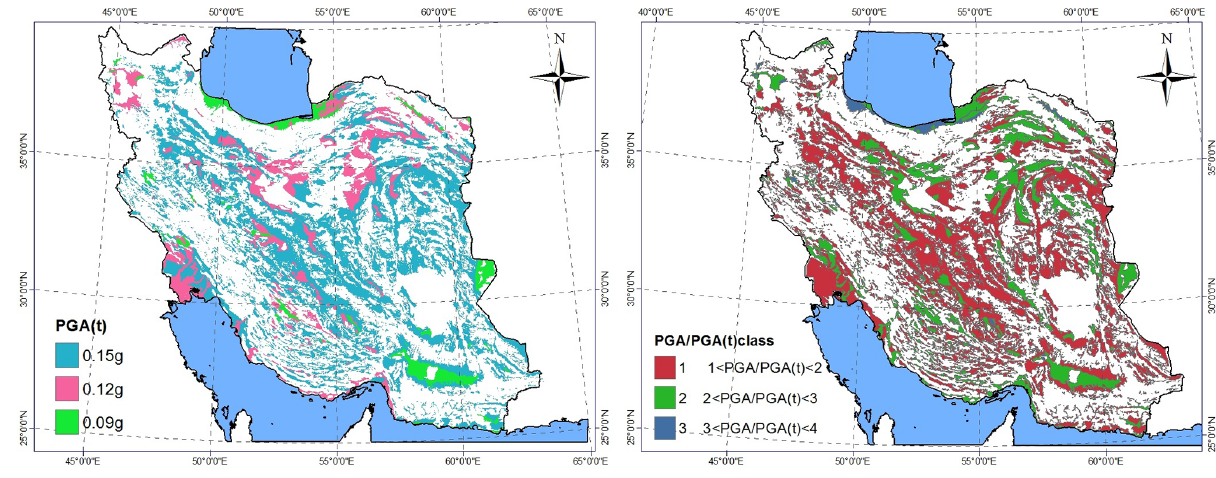
Figure 10. Mapping of the threshold ground acceleration PGA( t